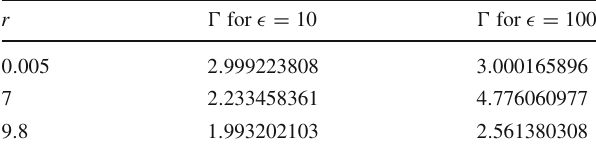
Table 4 Adiabatic index with DM for (cid:2) = 100